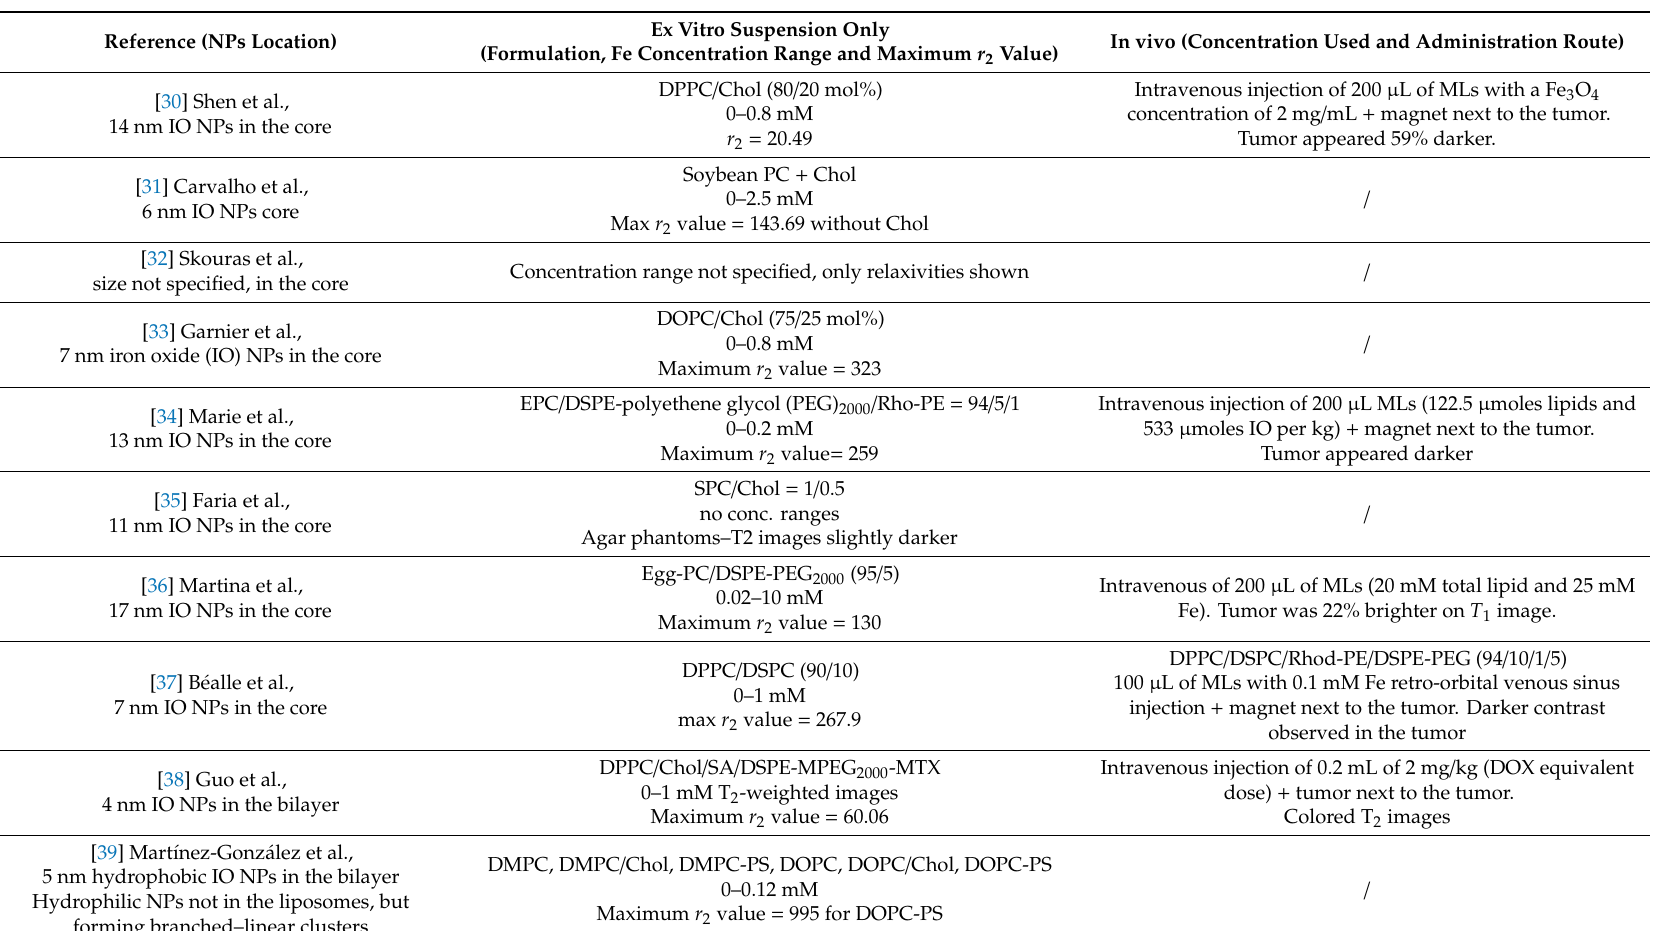
Table 1. List of all studies using magneto-liposomes for magnetic resonance imaging (MRI) applications with a summary of their experimental data (sizes of IO NPs and their locations in liposomes, liposomal formulation, concentration ranges used for the determination of r 2 , maximum r 2 values and in vivo conditions). Chol is abbreviation for